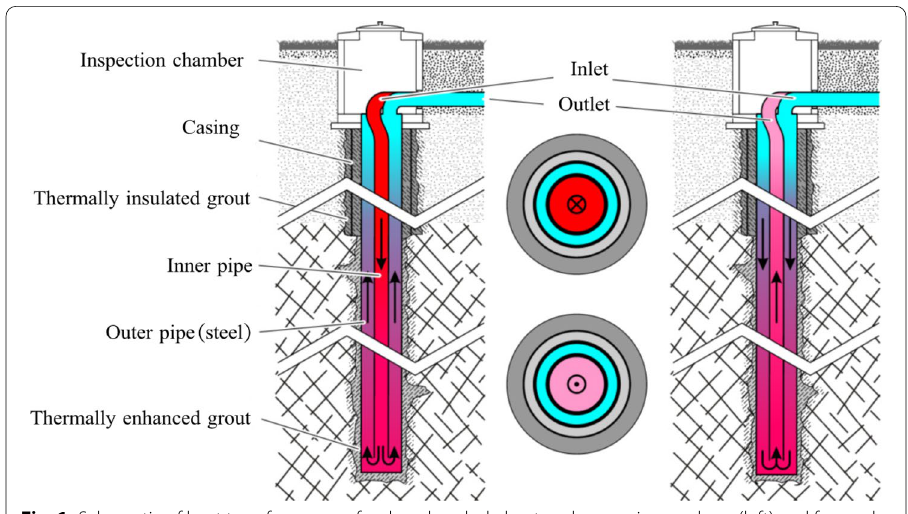
Fig. 1 Schematic of heat transfer process for deep borehole heat exchanger: inverse loop (left) and forward loop (right). Reproduced with permission from Elsevier from Bär et al. (2015); this work is licensed under the CC BY-NC-ND license (http:// creat iveco mmons. org/ licen ses/ by- nc- nd/4.